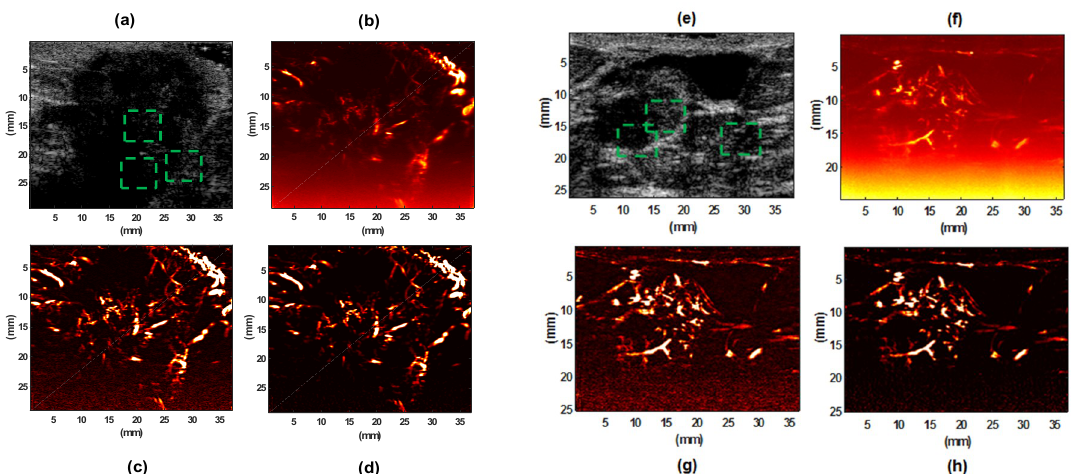
Figure 6. B-mode image of invasive ductal carcinoma (IDC) type III breast lesion ( a ) and IDC type II breast lesion ( e ); their gross vasculature SVD images ( b , f ), respectively; their vasculature images after SVD+TH ( c , g ), respectively; final images of vasculature after applying the proposed denoising method (NLM+TH) ( d , h ), respectively.